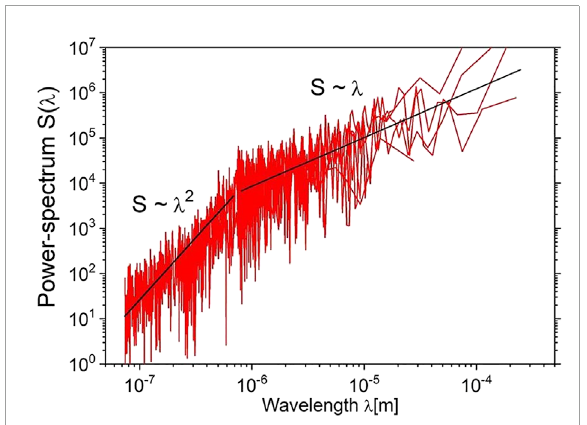
FIGURE 3 FFT spectrum of a longitudinal section, after integration of the transverse dimension, of untreated fabric fibers, obtained by superimposing the signal from the SEM images at all the